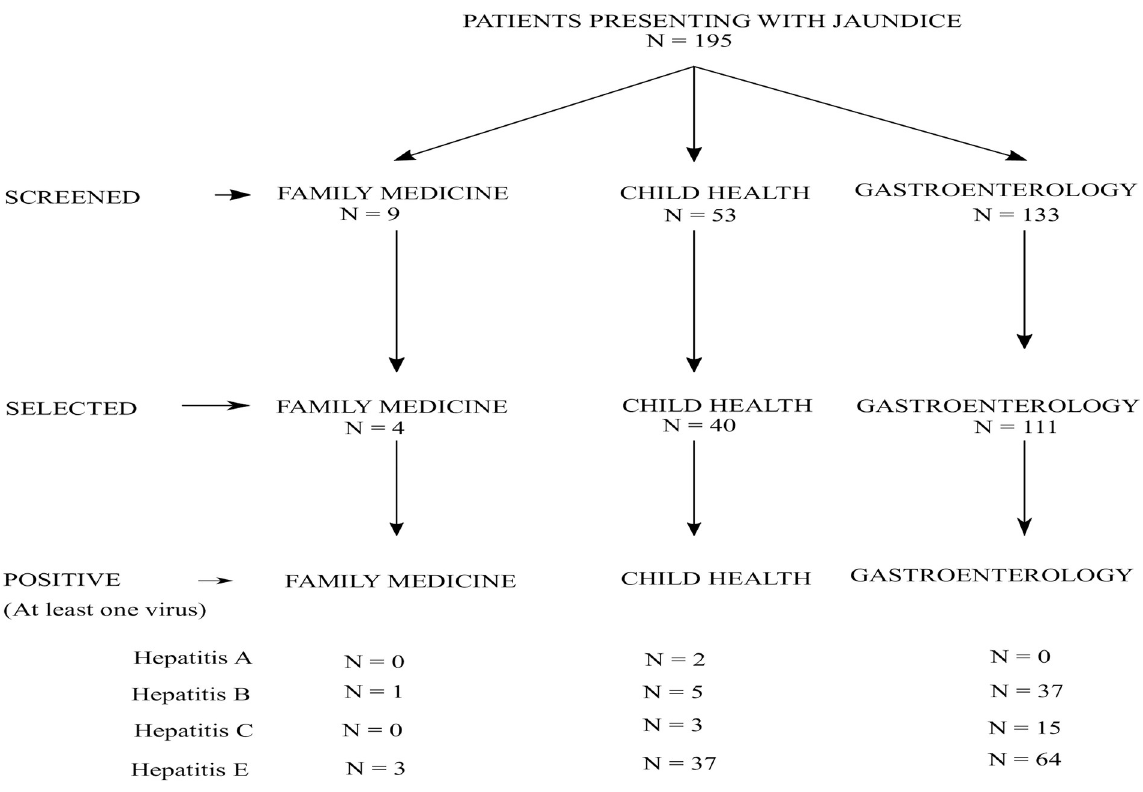
Fig 1. Flowchart of subject